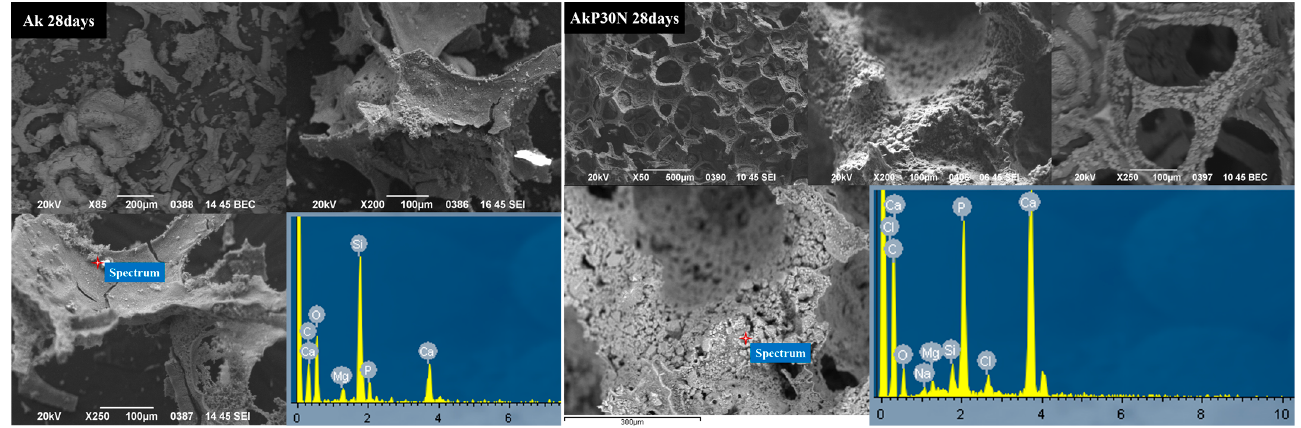
Figure 20. Micrographs of the akermanite (Ak) and composite akermanite/PLGA/NPs scaffolds (AkP30N) after 28 days of immersion in SBF.